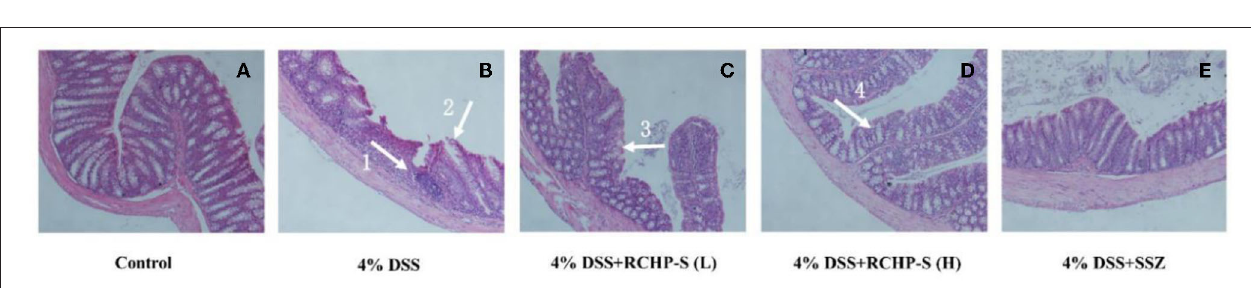
and anti-inflammatory drugs, we found scores for the high-dose polysaccharide and DSS groups were significantly different ( p < 0.05). DAI score results are shown in Figure 7C , indicating that the high-dose polysaccharide group can effectively alleviate colitis symptoms and protect the